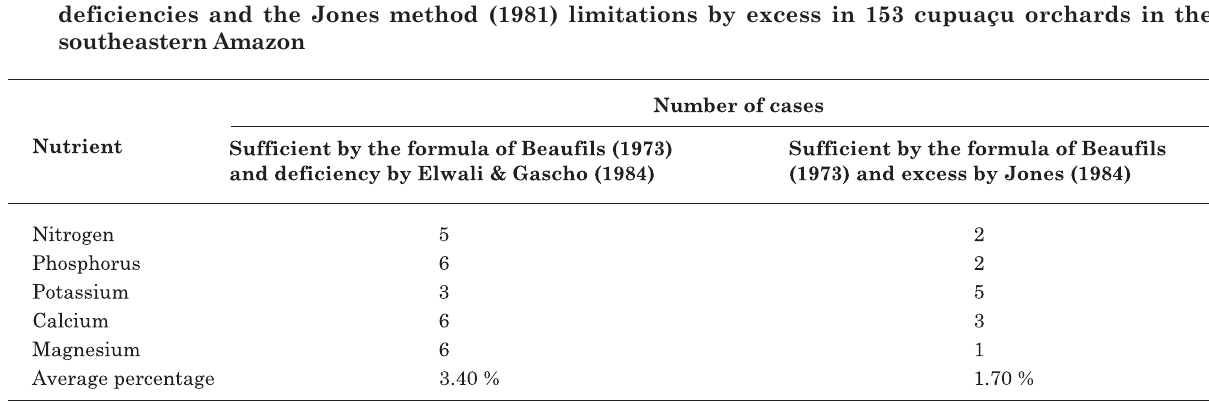
Table 5. Correlation coefficients of the DRIS indices for macronutrients obtained by the DRIS methods developed by Beaufils (1971), Jones (1981) and Elwali & Gascho (1984), based on the evaluation of the nutritional status of 153 cupuaçu orchards in the southeastern Amazon